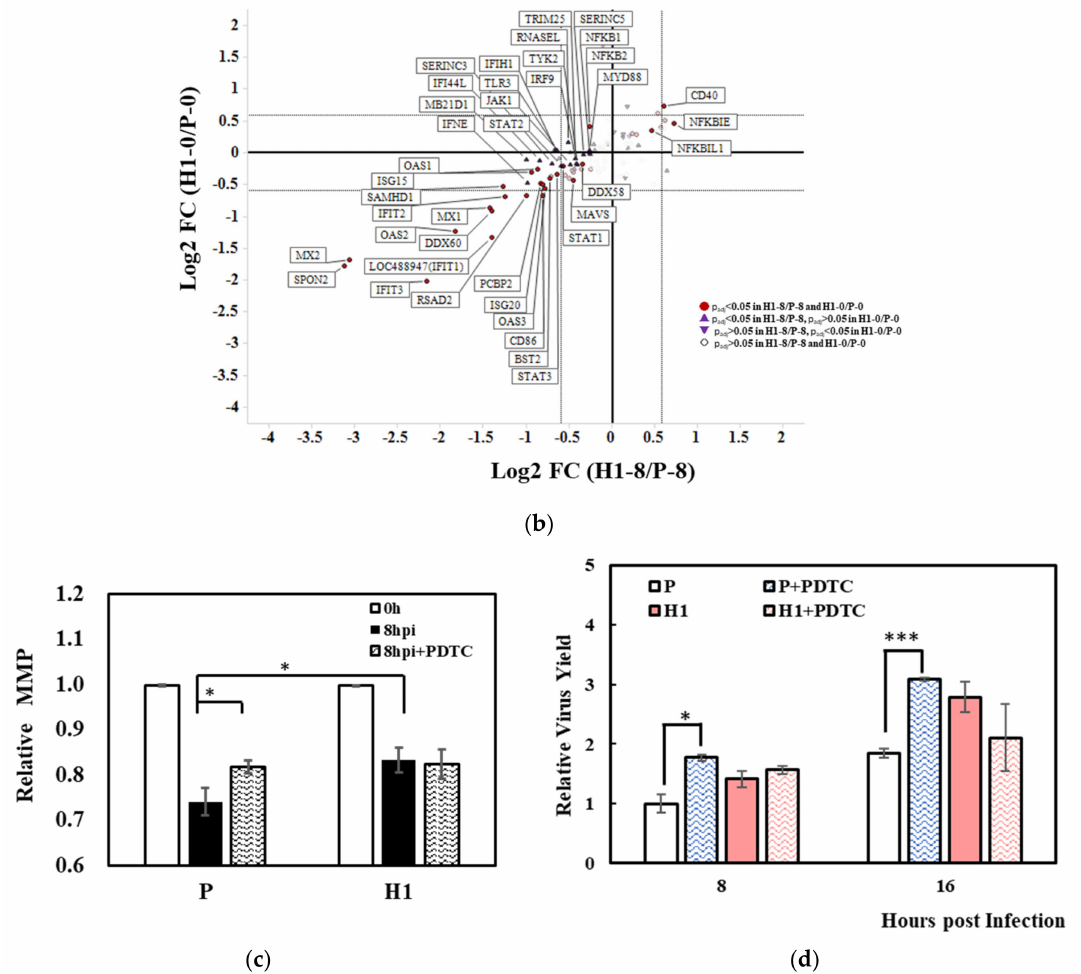
Figure 6. Reduced defense response to virus in H1 compared to P. ( a ) comparison of gene expression level of H1 and P in innate immune response against IAV infection at 0 h and 8 hpi. Each box represents a gene, different colors represent the Log2FC of H1/P (red: upregulated with p adj < 0.05, green: downregulated with p adj < 0.05, white: p adj > 0.05 or average TPM < 1), colors shown in the left of the box represent the comparison at 0 h; in the right they right represent the comparison at 8 hpi. Diagram adapted from Chen, et al. [30] ( b ) comparison of expression levels of anti − viral genes or ISGs in H1 and P before and after virus infection (purple triangle represents genes with p adj < 0.05 in comparison H1–0/P–0, inverted triangle represents genes with p adj < 0.05 in comparison H1–8/P–8, red circle represents genes with p adj < 0.05 in both comparisons). ( c ) effect of PDTC addition in H1 and P on mitochondrial membrane potential. ( d ) effect of PDTC addition in H1 and P on specific virus yield. Experiments were done in triplicated infections. * p < 0.05, *** p <